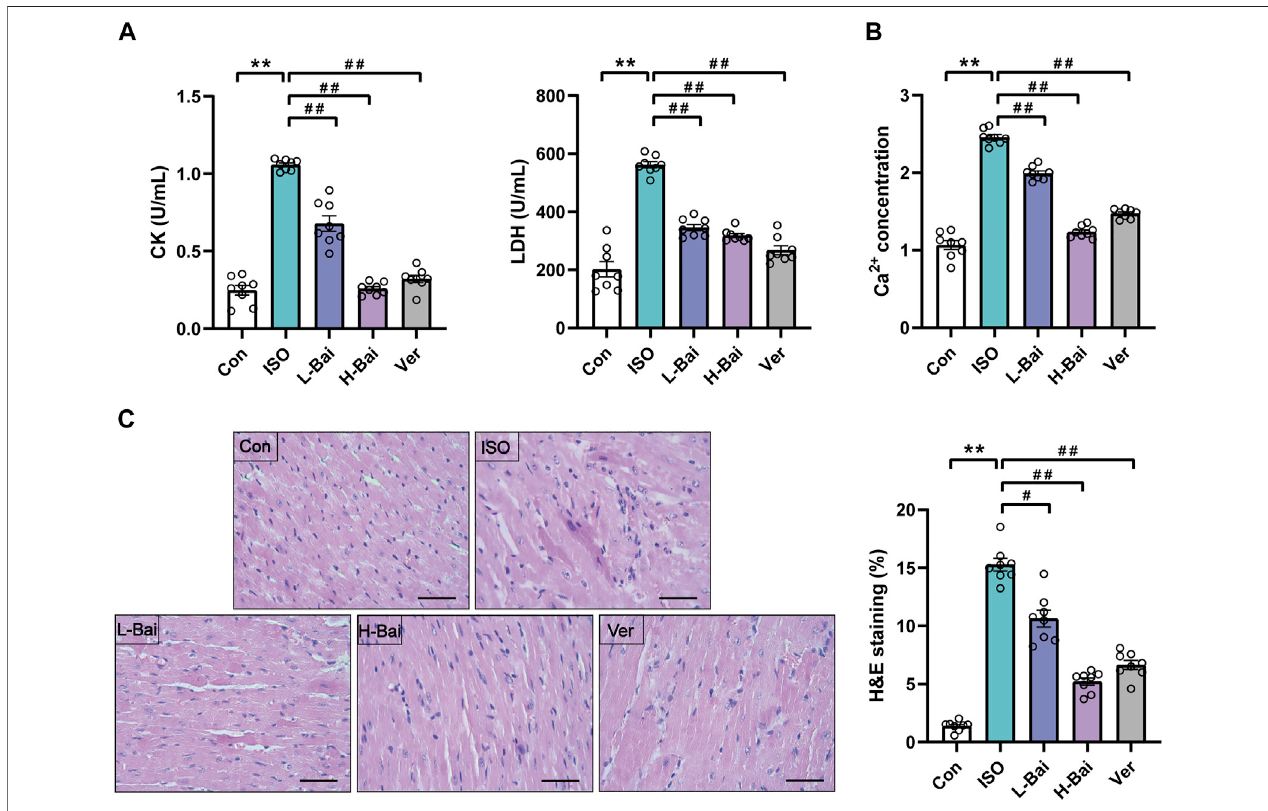
FIGURE 3 | (A) Effects of Bai on levels of creatinine kinase and lactate dehydrogenase (CK and LDH, respectively) (B) concentration of Ca 2+ in mice. (C) Representative heart histopathological images from Con, ISO, L-Bai, H-Bai, and verapamil (Ver) in mice, and the area of myocardial injury in each group was calculated. Scale bar = 50 μ m (magni fi cation: